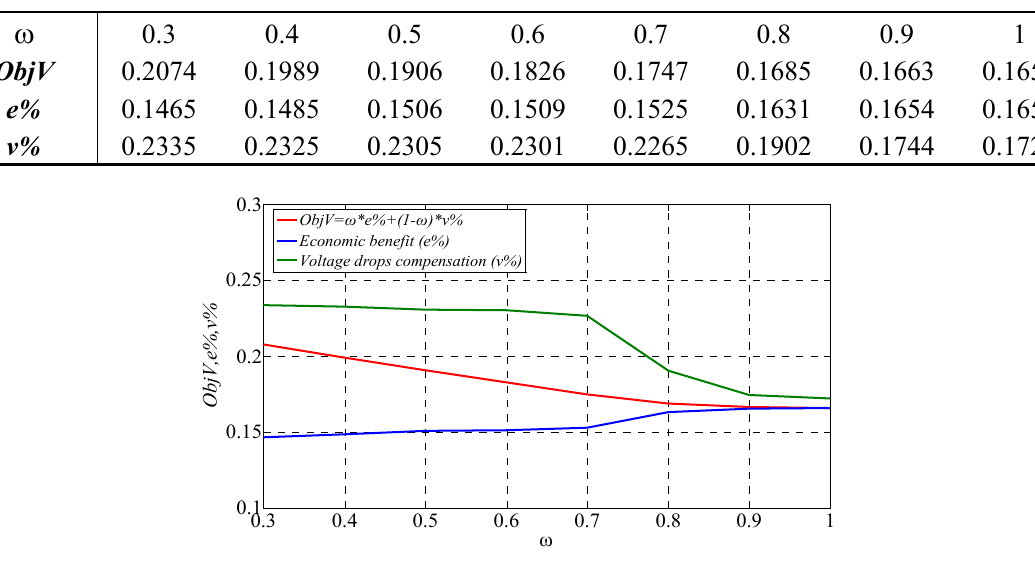
Figure 19. Optimal ObjV , e% and v% obtained by the novel optimization